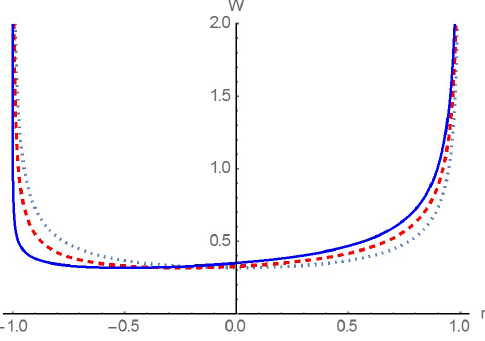
Figure 4. The total flooding time (the solid curve) and the drainage time (the dashed curve) depending on the parameter